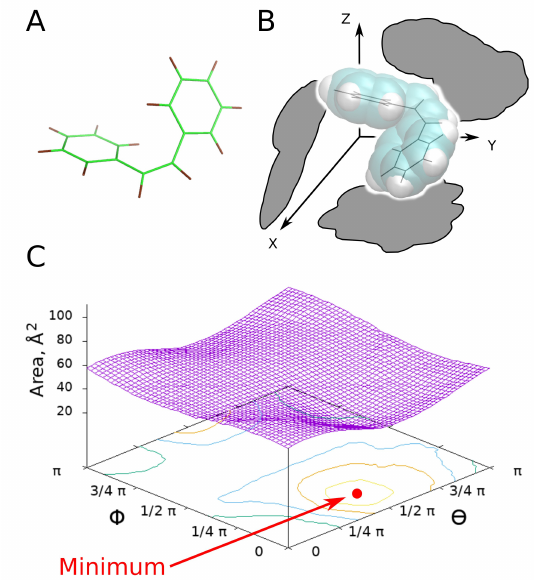
Figure 3. Algorithm of the projection area calculation. ( A ) Optimized geometry of cis stilbene. ( B ) cis stilbene with accurate van der Waals radii and its projections onto three planes. ( C ) Change in the XY projection area upon the molecule rotation around the X (angle Θ ) and Y (angle Φ )